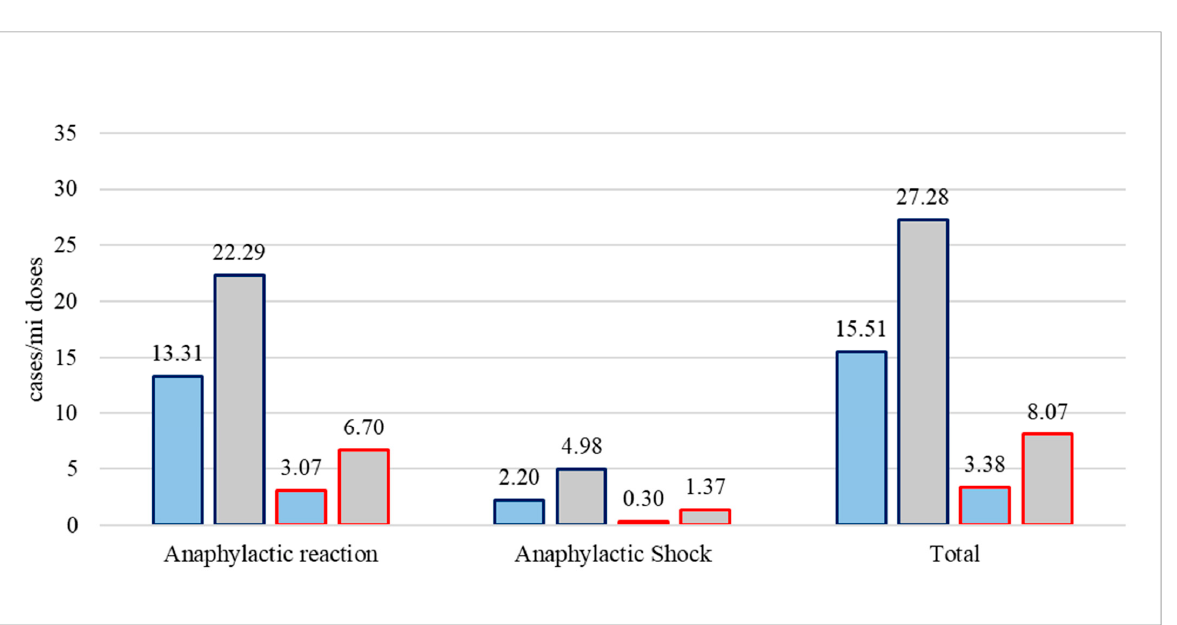
Figure 1. Rates of estimated anaphylactic reaction and anaphylactic shock post-COVID-19-